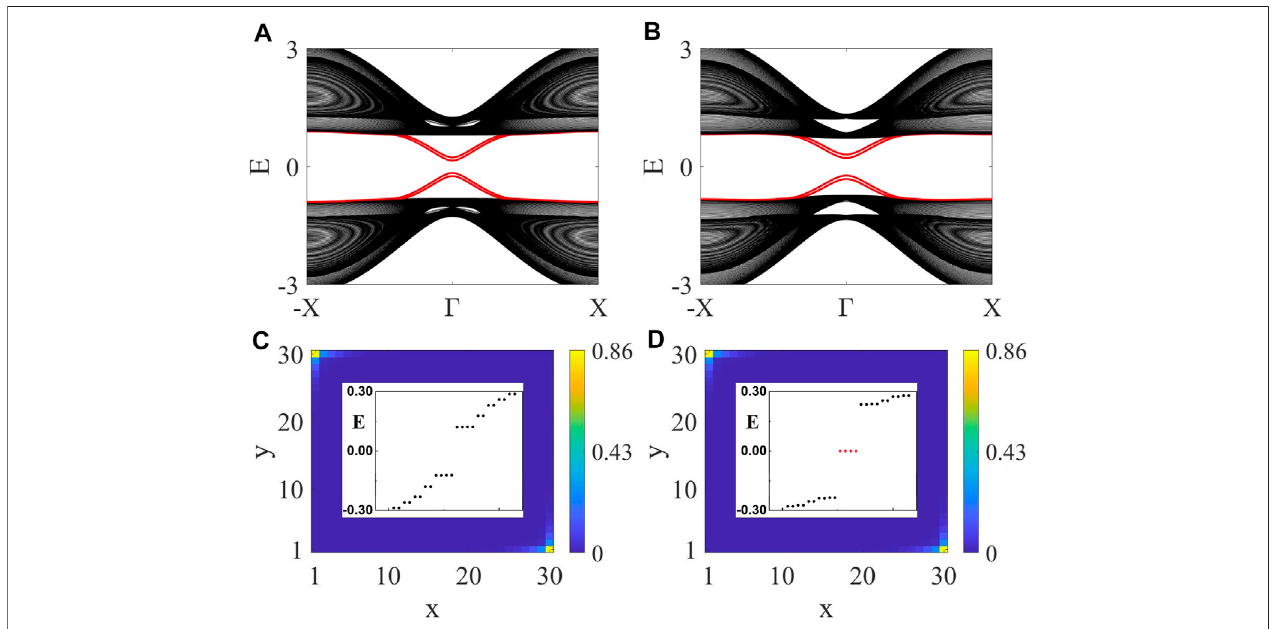
FIGURE7| (Color online)The effect ofanin-plane antiferromagnetic-type Zeeman fi eldonthecorner states. Chosen parameters are: t = 1, m =1, λ =1, η =0.2. In (A) and (C) , B x = 0.2, B y = 0. The Zeeman fi eld shifts the energies of the corner states away from zero. In (B) and (D) , B x = B y = 0.2. There are four corner states with energies accidentally pinned to zero due to the special choice of the Zeeman fi eld. N y = 100 in (A) and (B) .